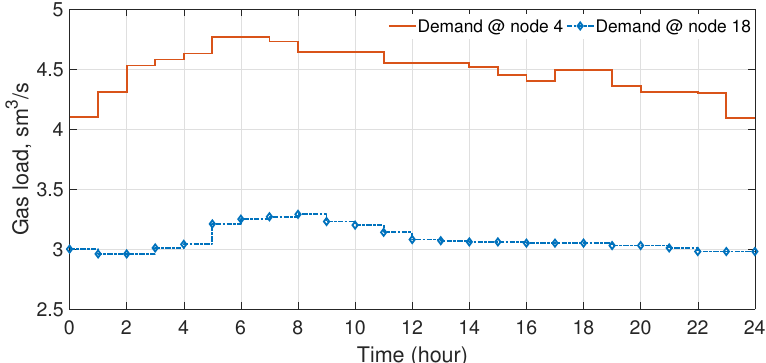
Figure A1. Gas load values at node 4 (gas-fired power generator), and node 18 as non-power